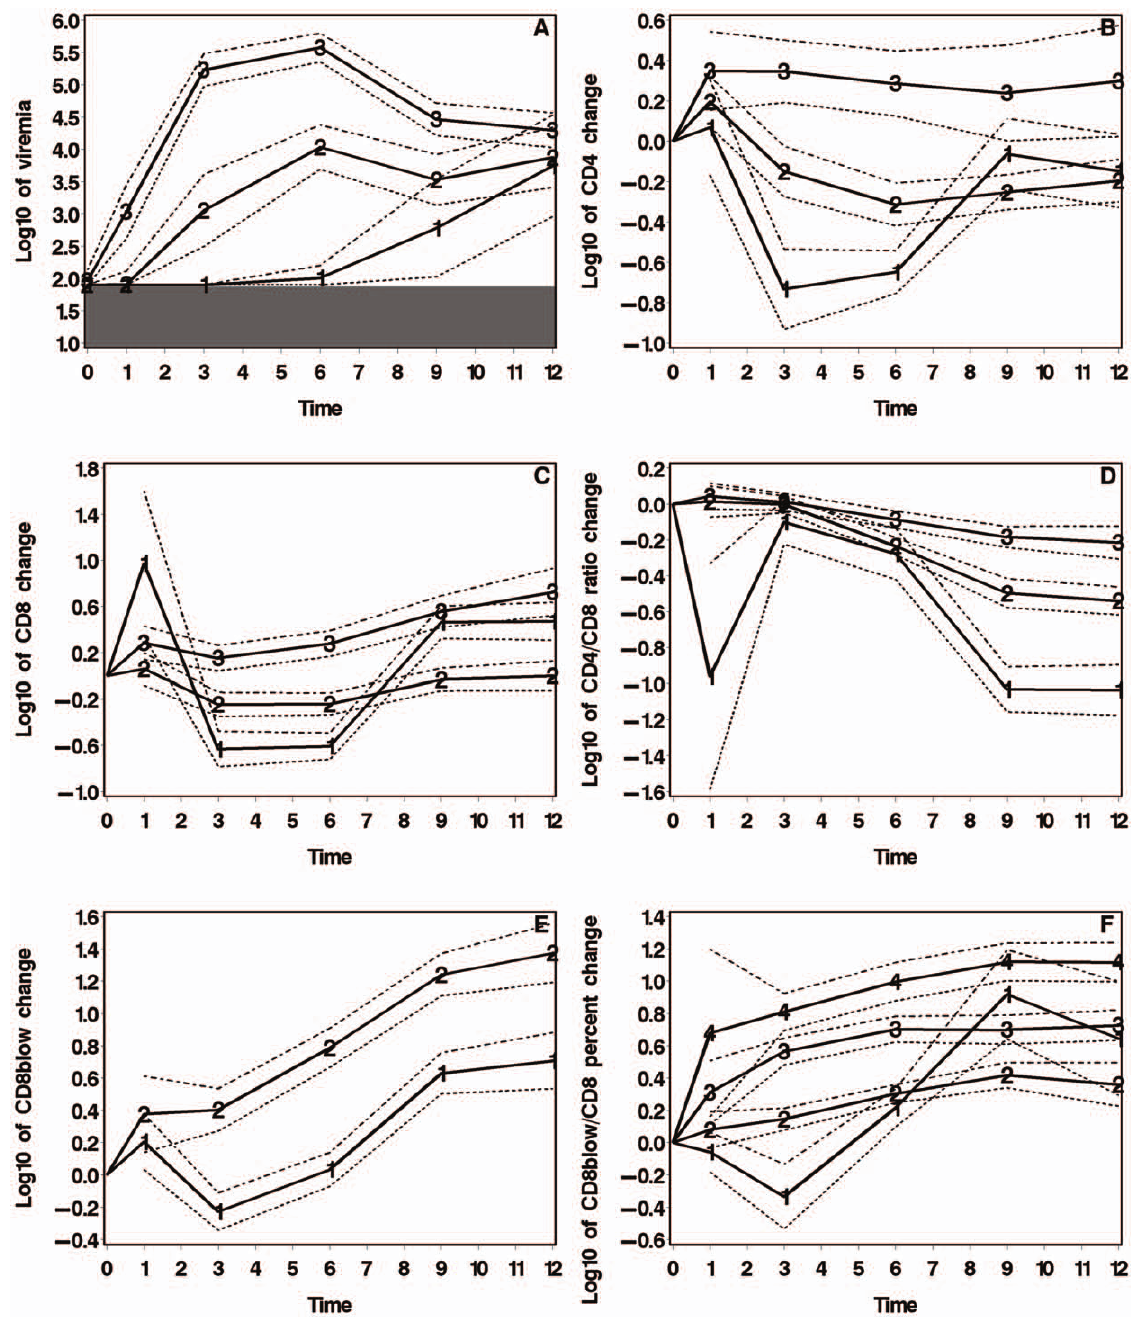
Figure 1. Trajectory-groups. Trajectory-groups (with 95% confidence intervals) for viremia and changes in T-cell markers over time since contamination (in weeks). Viremia is expressed in log 10 of viral RNA copies per mL of plasma. The hatched area indicates the area below the virus detection threshold (1.9). Each T cell marker is expressed as the predicted value of log 10 ( X w / X 0 ) where X 0 is the value at baseline and X w the value at week w (1 to